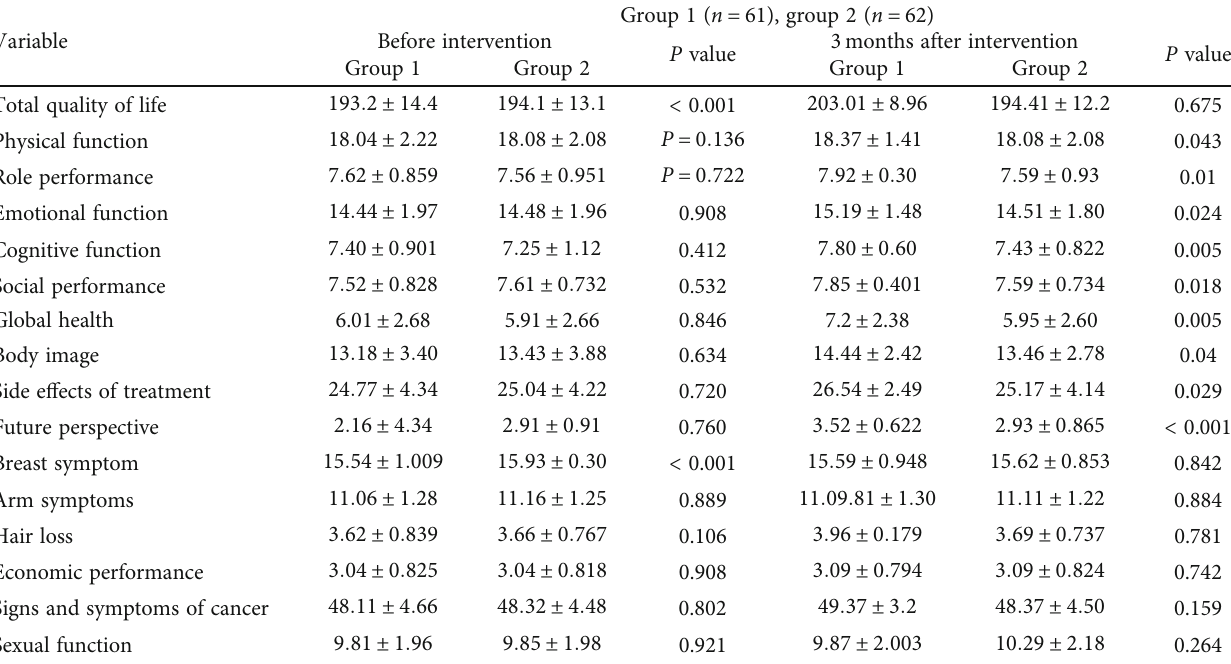
Table 4: Comparison of quality of life score in intervention and control